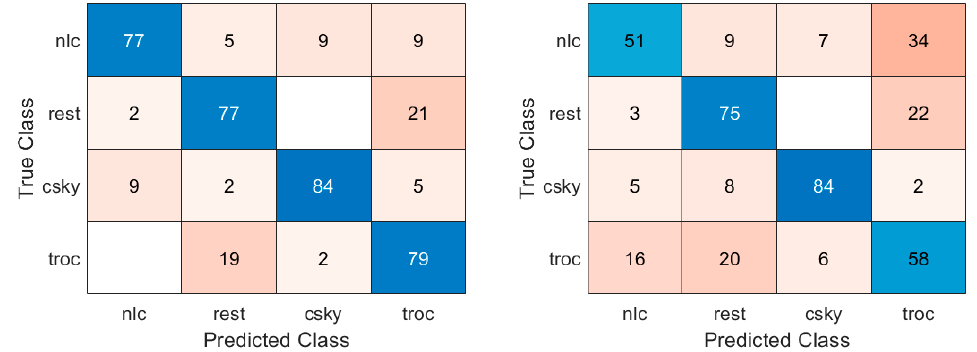
Figure 9. Confusion matrices for the four categories when using mean, standard deviation, min and max values (on the left) and using HLAC (on the right).